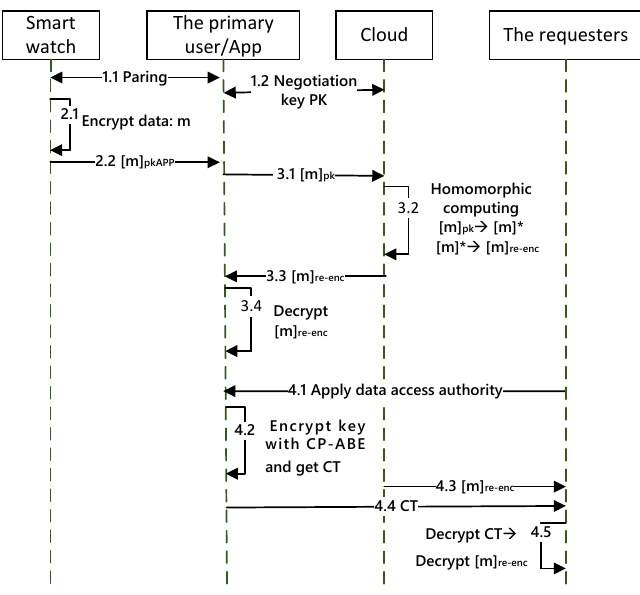
Figure 5. The data flow of